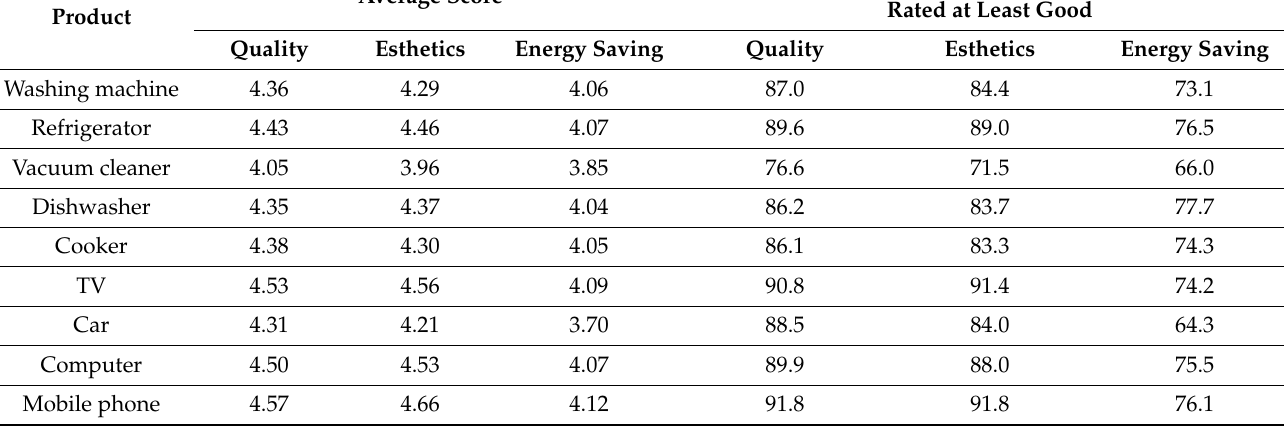
Source: own study. Table 5. Self-assessment of owned and used products in the household in terms of: quality of workmanship, esthetics and energy efficiency. Percentage of Respondents for Whom the Product Was Average Score * Rated at Least Good Product Quality Esthetics Energy Saving Quality Energy Saving Washing machine